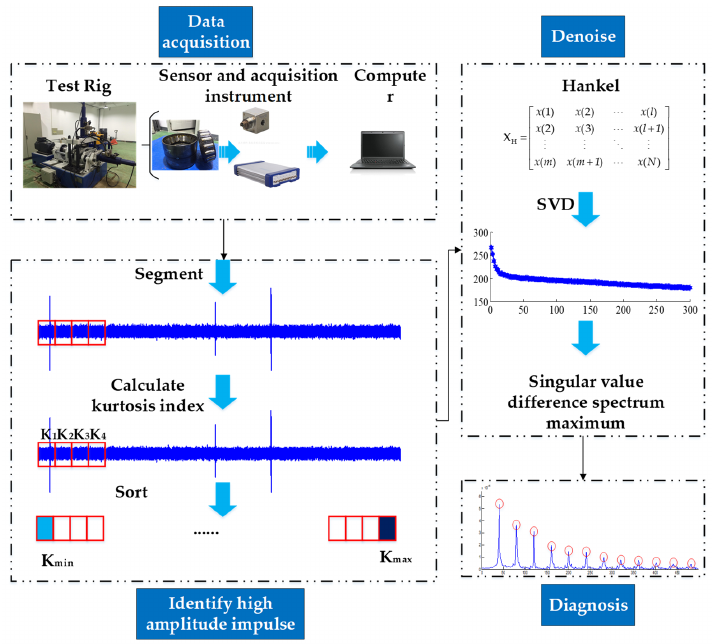
Figure 1. A flow chart of the algorithm for pre-identifying singular value decomposition.